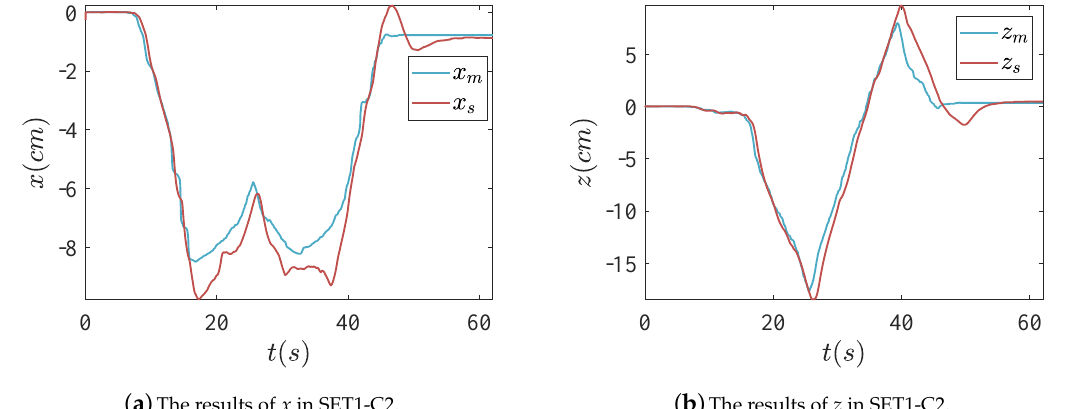
Figure 10. The results of Set1-C1.